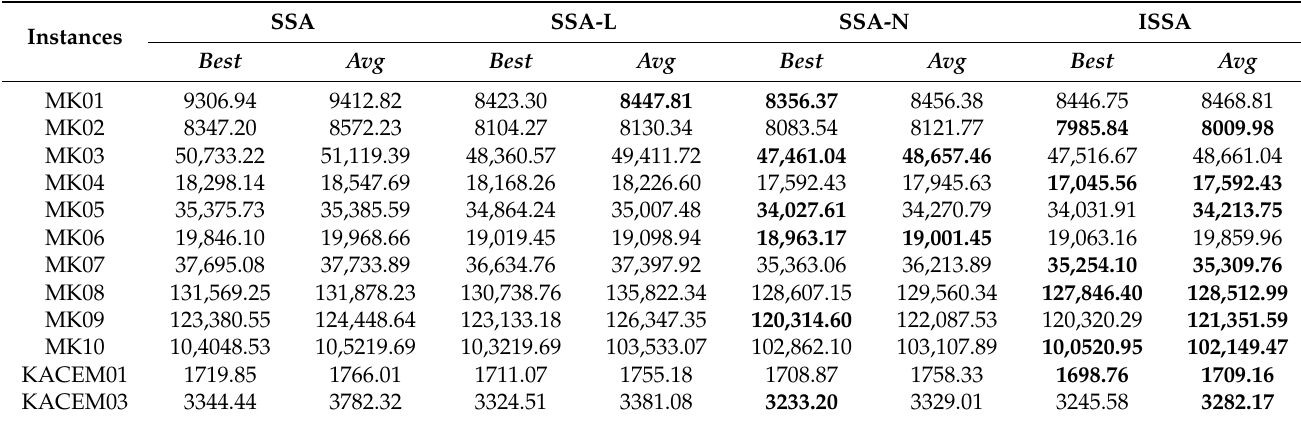
Table 3. Effectiveness analysis of improvement